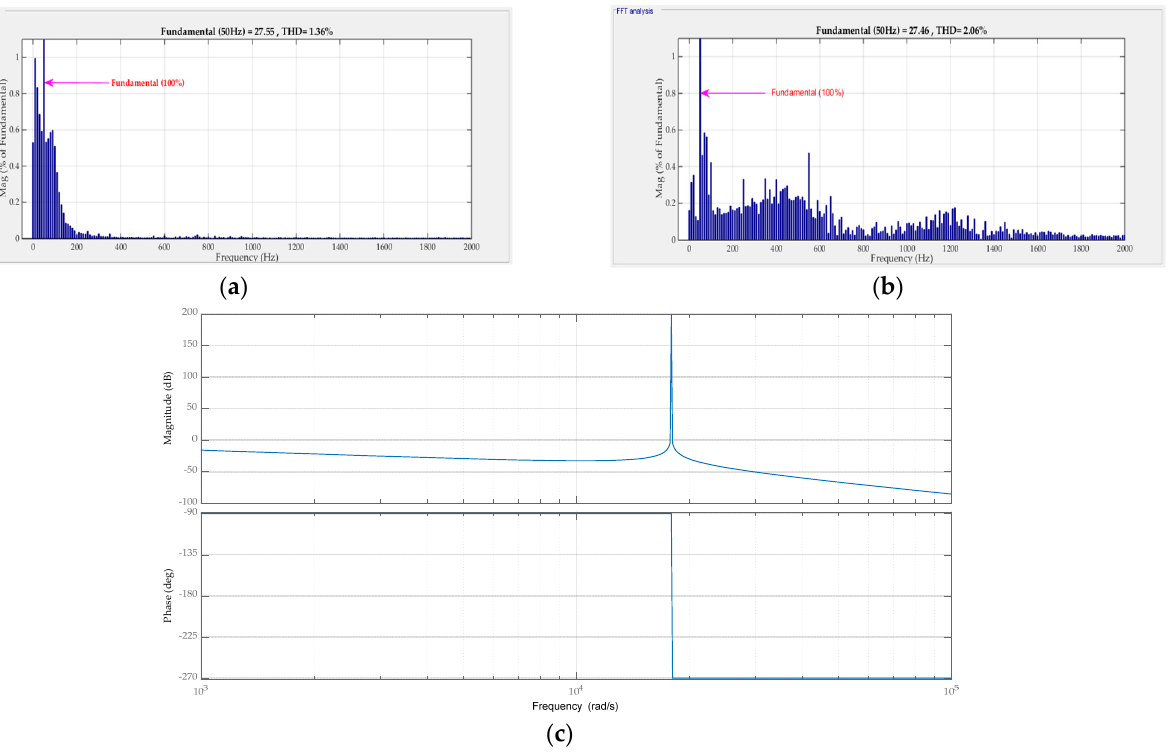
Figure 8. The spectrum of I g for ( a ) a strong-grid, ( b ) a weak-grid (@100%insolation), and ( c ) the LCL filter frequency response.